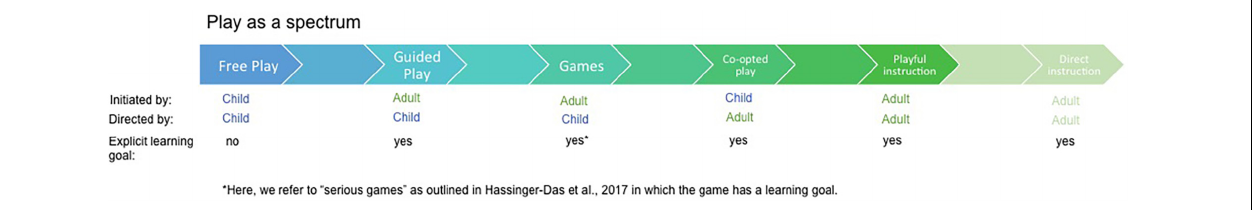
It is important to note that these characteristics align